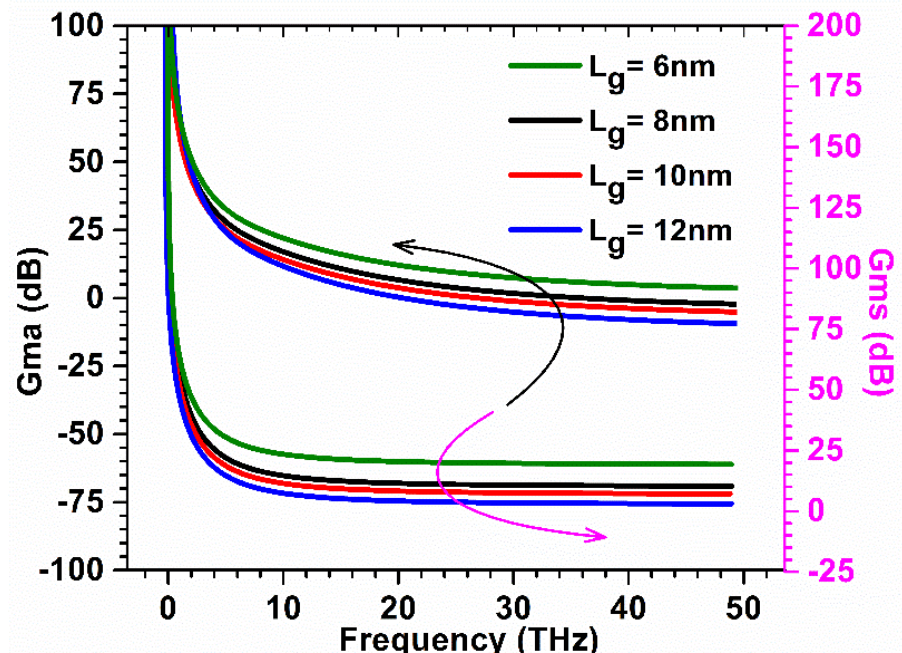
Figure 10. Gma and Gms at various gate lengths of GaN-SOI-FinFET. The Stern stability factor was also observed for different gate lengths as a function of frequency for GaN-SOI-FinFET, as shown in Figure 11a. From Figure 11a, it was observed that the Stern stability factor improved (slightly < 1) for reduced gate length (6 nm) in the proposed device at a higher frequency and it is desirable for the designing of RF amplifiers. f T was extracted from the current gain plot at unity current gain (shown in Figure 11a) for various gate lengths at very high frequencies. When gate length is reduced from 12 nm to 6 nm, f T increases by 28% due to a reduction in stray capacitances, as clearly reflected in Figure 12a.